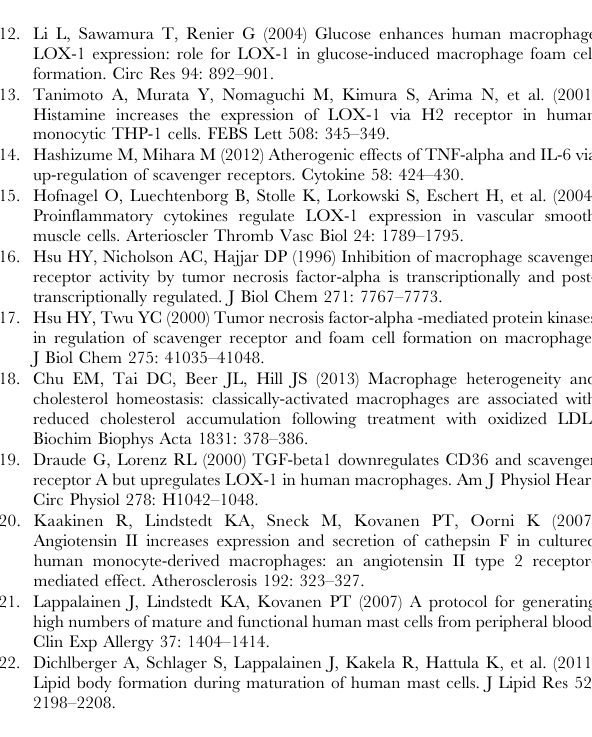
Figure S1 Concentration-dependent effect of LAD2 mast cell releasate on macrophage LOX-1 mRNA expression.